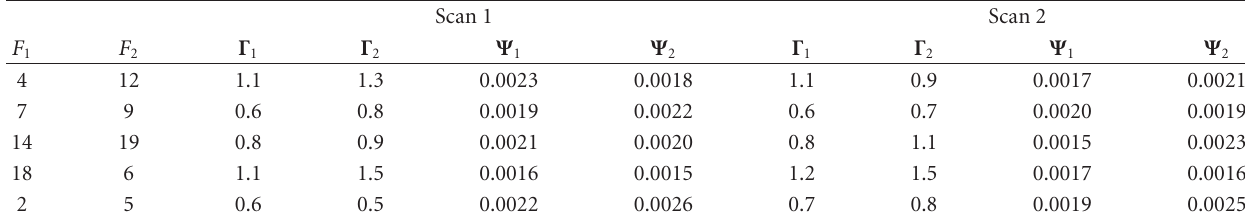
Table 4: Symmetry errors [mm] for Γ 1 , Γ 2 , Ψ 1 , and Ψ 2 are given for random frames ( F 1 and F 2 ) of the two cardiac cine MRI scans.